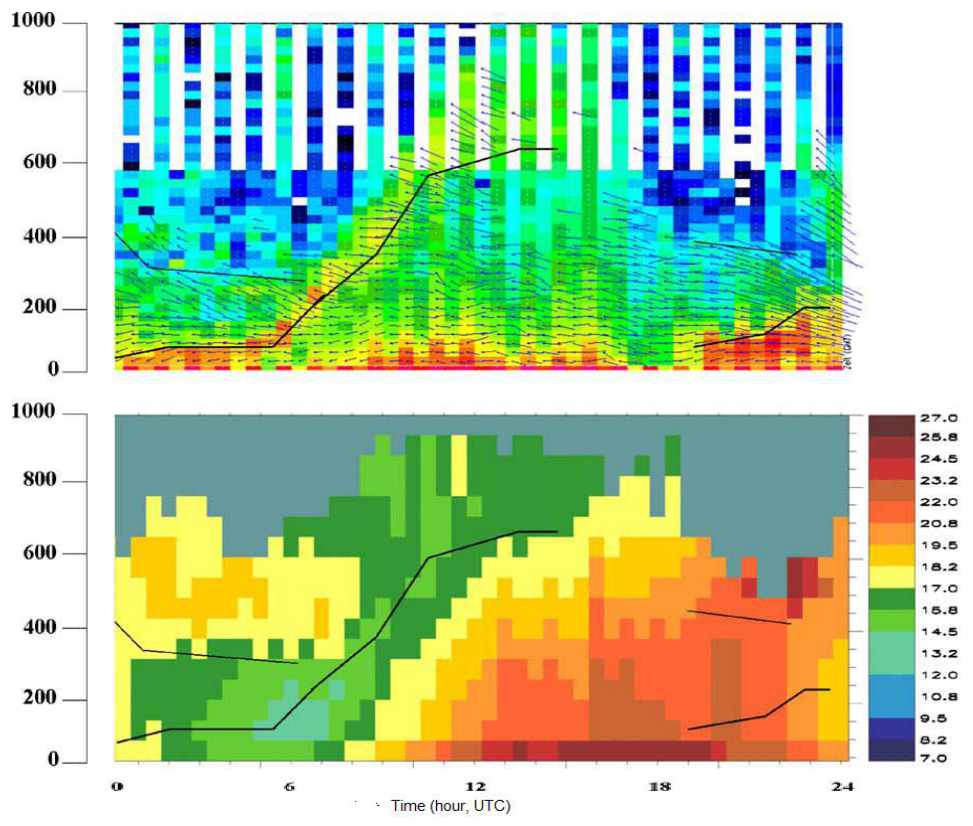
Figure 1. Top frame: Sample RASS backscatter intensity and horizontal winds profiles. Bottom frame: The estimated temperature profile in degrees Celsius